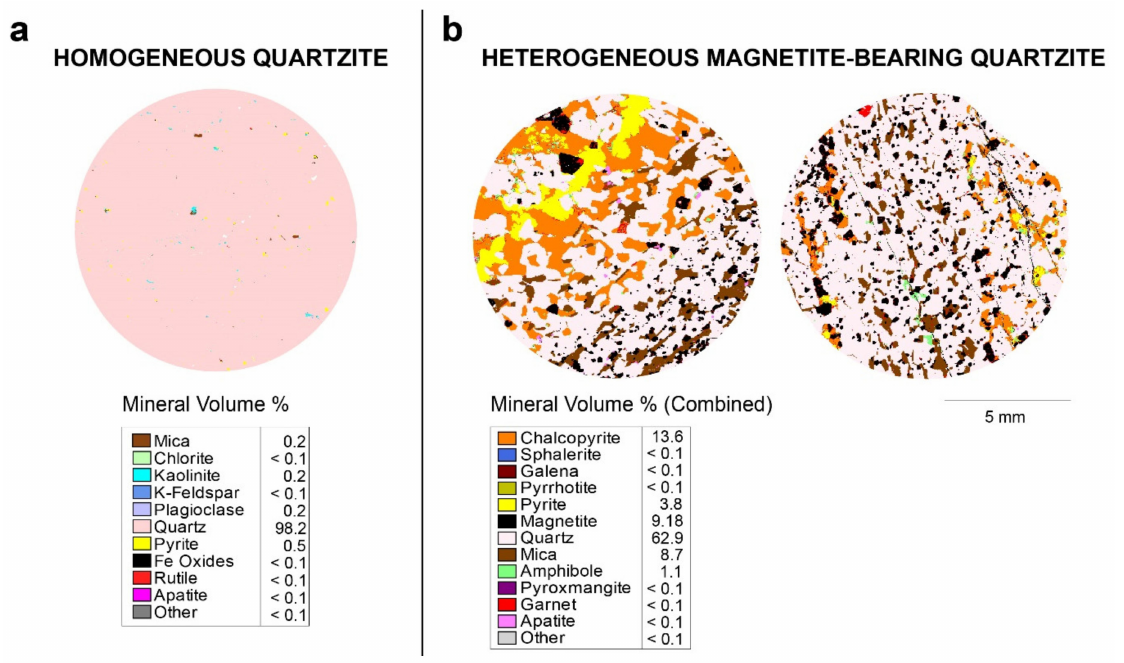
Figure 4. QEMSCAN false colour images of the two reference samples; ( a ) quartzite and ( b ) magnetite-bearing quartzite. Two image sections of the magnetite-bearing quartzite are shown given the heterogeneity of the